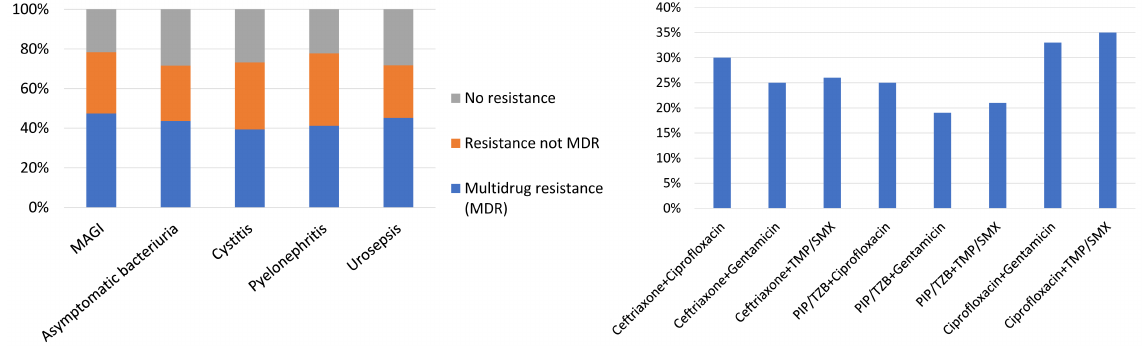
Figure 5: Resistance patterns to antibiotics in patients with HAUTIs from the GPIU study 2003–2013; left: prevalence of multidrug resistance (MDR) microorganisms; right: resistance rates for the main groups of antibiotics [29]; MDR: multidrug resistance, MAGI: male accessory gland infection, ASB: asymptomatic bacteriuria, Cefta: ceftriaxone, Cipro: ciprofloxacin, Genta: gentamicin, TMP/SMX: trimethoprim-sulfamethoxazole, Pip/Tzb: